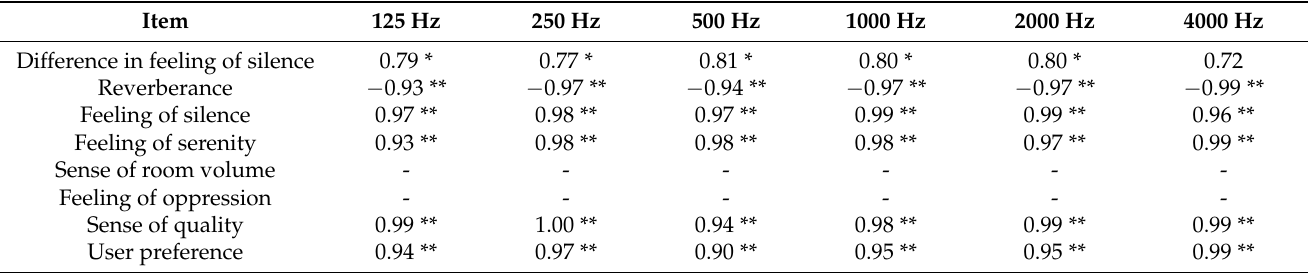
Table 3. Correlation coefficients between the average absorption coefficients and psychological values of each evaluation